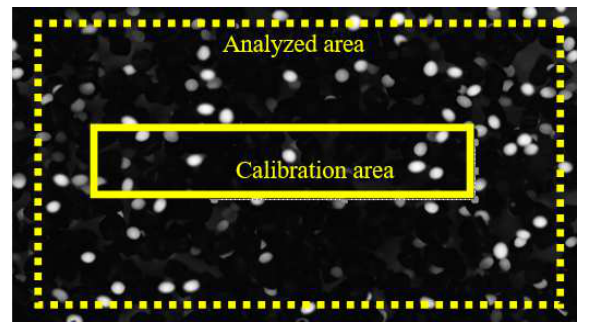
Fig. 5. Example of observed area .